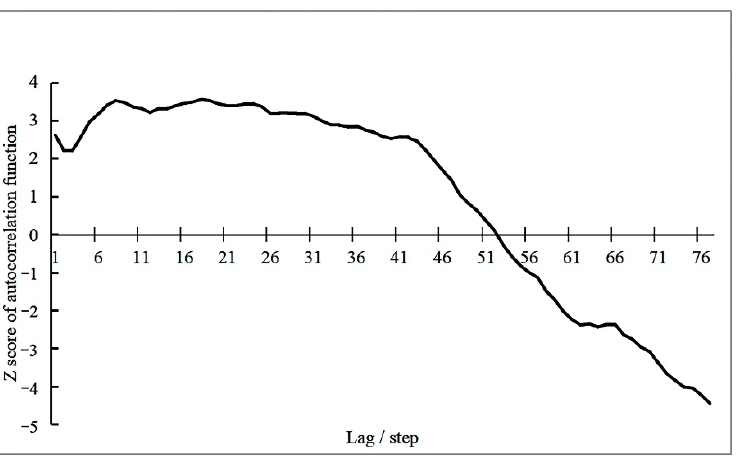
Figure 9. Time sequence sample autocorrelation function Z score diagram.